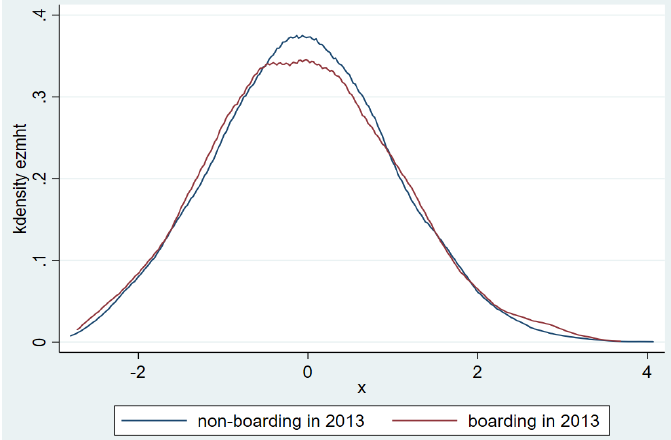
Figure 3. Distribution of students’ standardized MHT scores in samples from 2013.